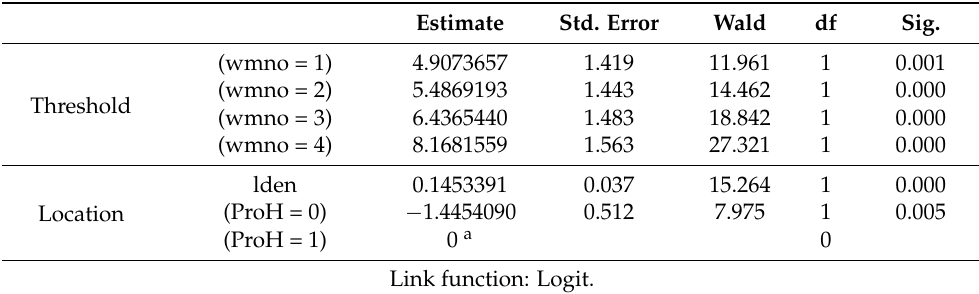
Table A6. Estimated parameters of the relationship between noise exposure (L den ) and wind turbine noise annoyance with control for whether people agree or are ambivalent/disagree whether Norway should prioritize hydro power. N =